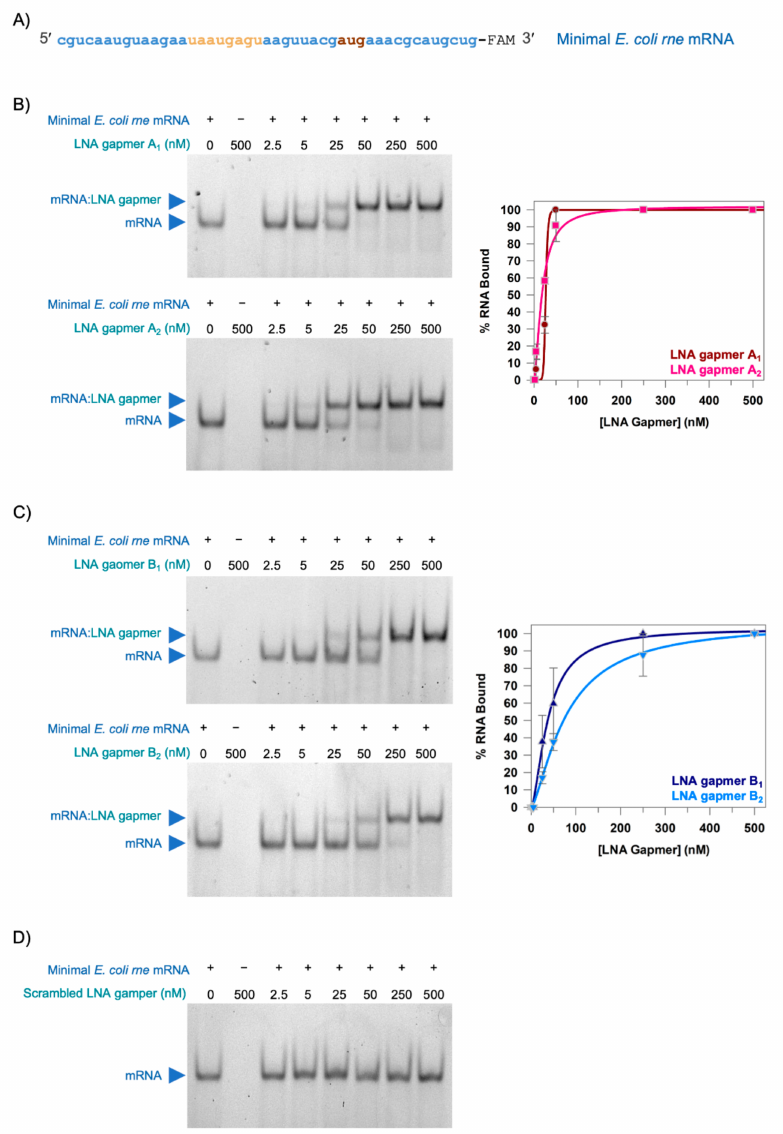
Figure 2. LNA gapmers bind to the translation initiation region of E. coli rne mRNA. ( A ) 3 (cid:48) FAM- labelled 45-mer minimal E. coli rne mRNA (blue; RBS, gold; start codon, brown). ( B – D ) Representative 12% native-PAGE of minimal E. coli rne mRNA incubated with increasing concentrations of LNA gapmer as described in Materials and Methods. ( B ) LNA gapmers A 1 and A 2 . ( C ) LNA gapmers B 1 and B 2 . ( D ) Scrambled LNA gapmer. The contrast in the images has been adjusted to aid visualisation. The minimal E. coli rne mRNA was present at 50 nM, where indicated (+). The LNA gapmers were present at the indicated concentration. The migration positions of the minimal E. coli rne mRNA (mRNA) and the complex of the minimal E. coli rne mRNA and the LNA gapmer (mRNA:LNA gapmer) are indicated (blue triangles). Plots of percentage minimal E. coli rne mRNA bound against LNA gapmer concentration are shown in ( B ) LNA gapmers A 1 and A 2 and ( C ) LNA gapmers B 1 and B 2 . Data are the mean from three experimental repeats and error bars represent the standard error of the mean (SEM). Data were fit (solid line) to a cooperative binding equation as described in Materials and